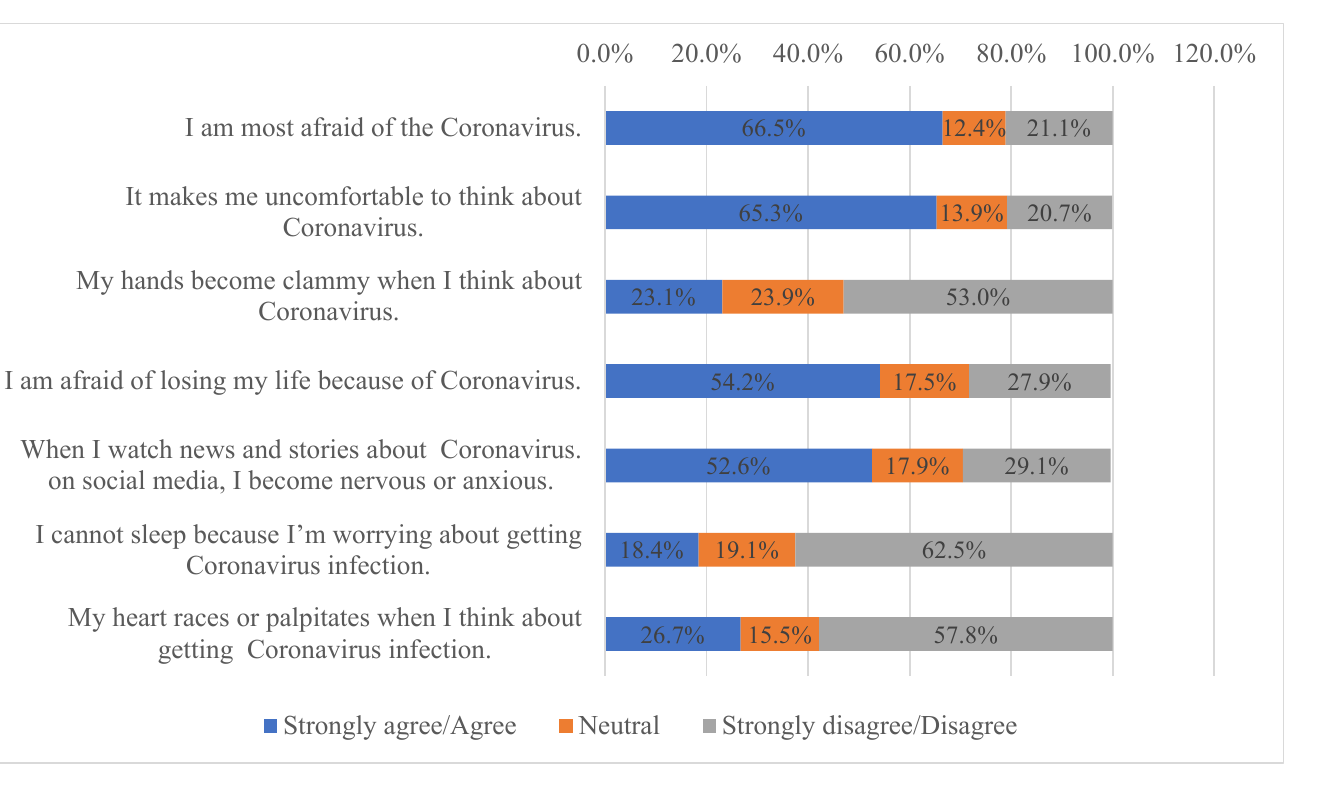
Figure 1. Patient’s perceptions of fear represented by percentages of those who strongly agree/ agree, were neutral, or strongly disagree/disagree with each statement.